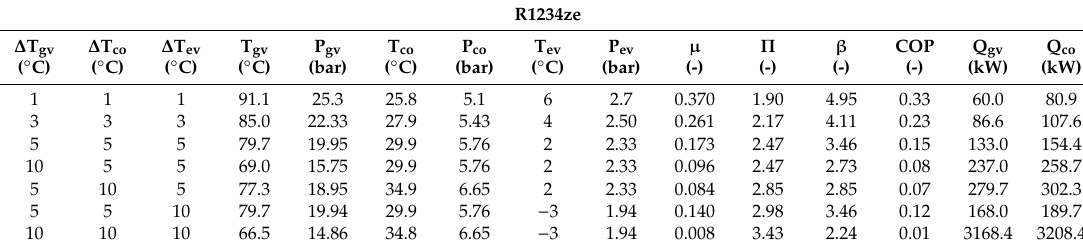
Table A1. Thermodynamic analysis results for R1234ze.